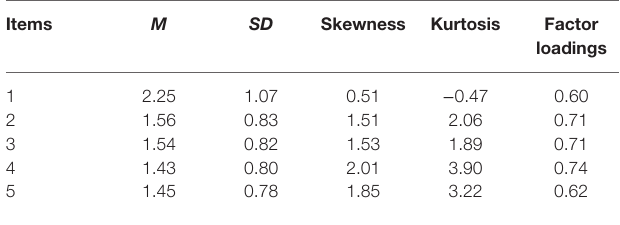
TABLE 2 | Descriptive statistics of the E5 items and confirmatory factor analysis (CFA) standardized factor